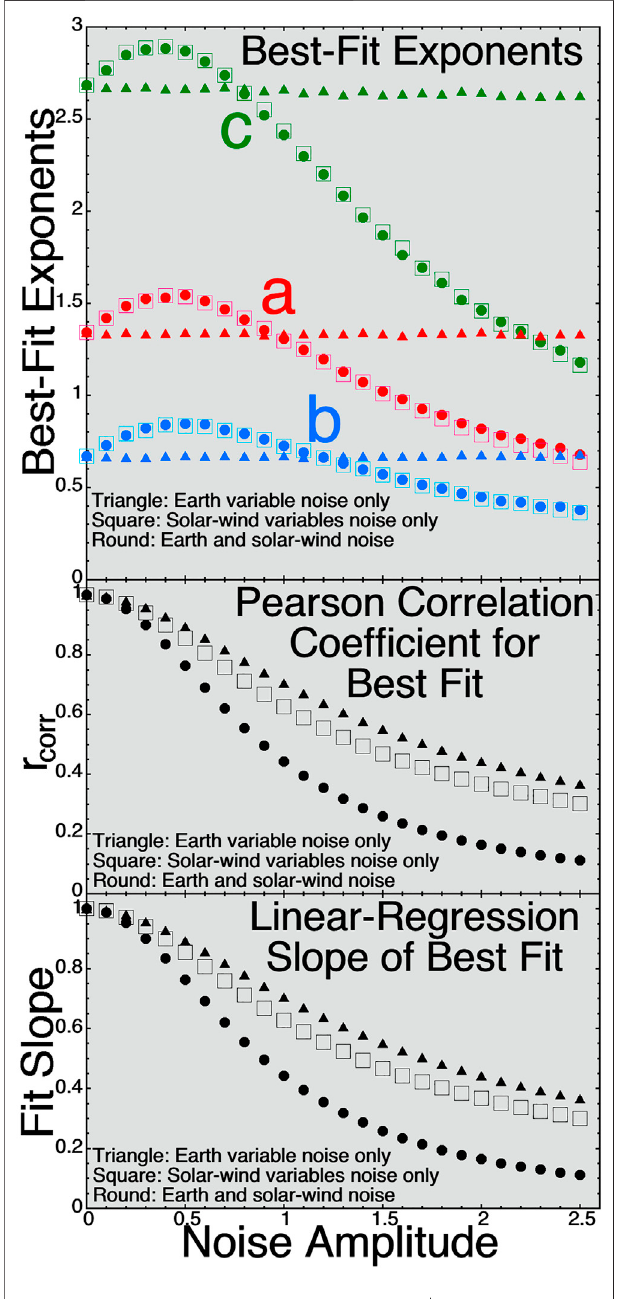
FIGURE 2 | For a driver function of the form d = v 1a v 2b v 3c for three independent solar-wind variables v 1 , v 2 , and v 3 , the exponents (A – C)